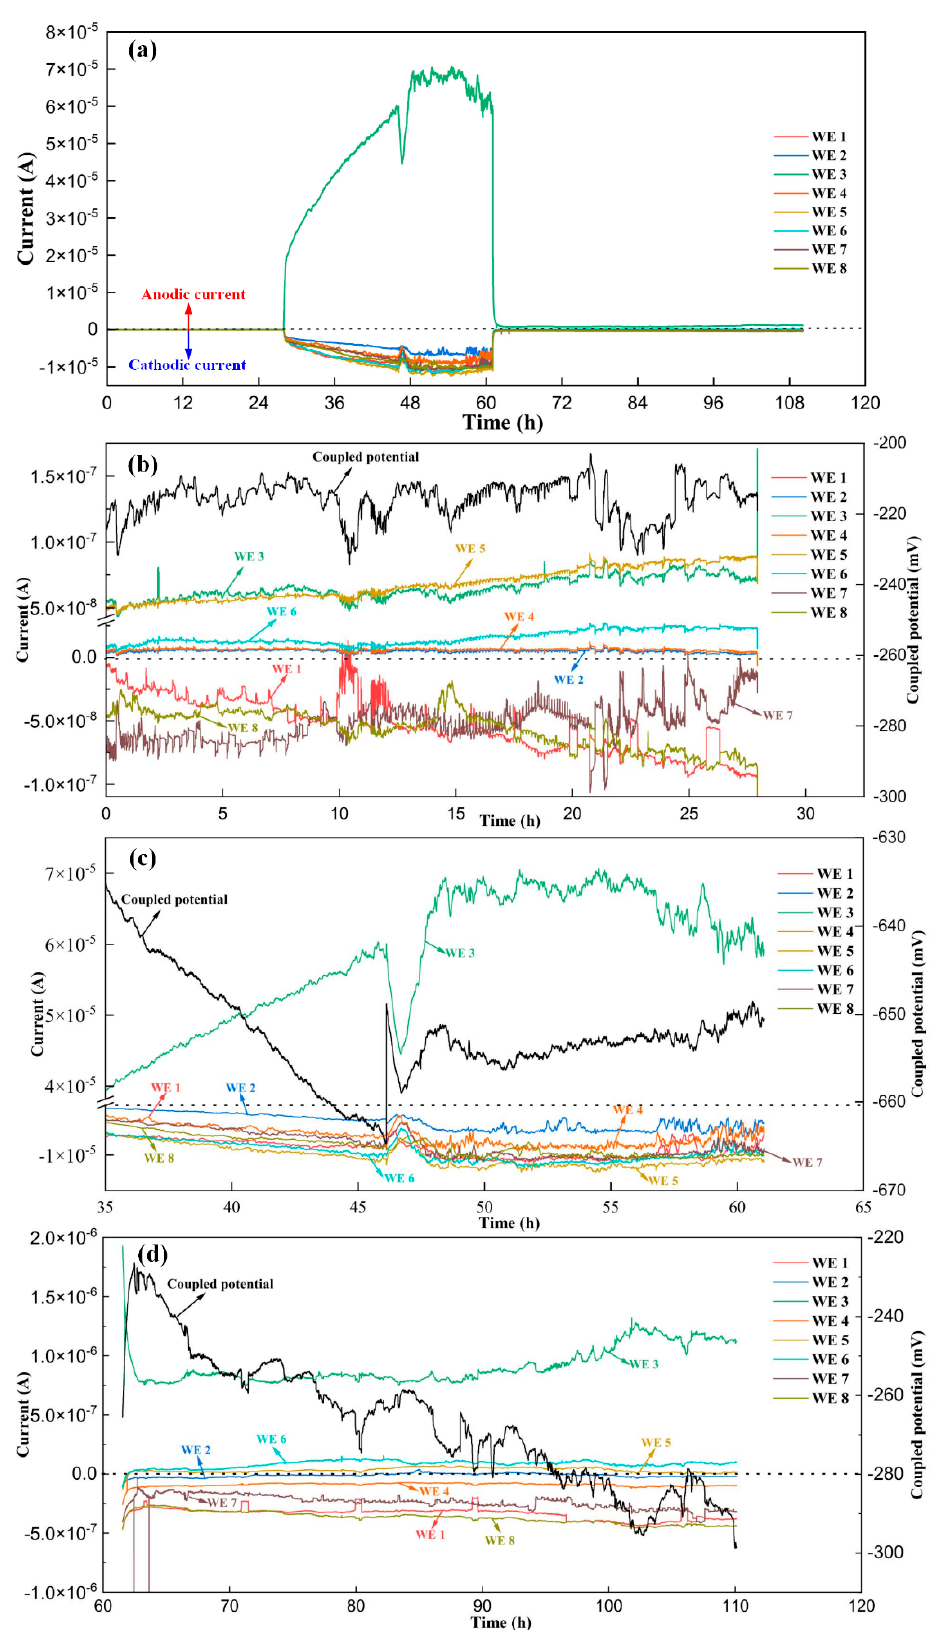
Figure 4. Time dependence of the galvanic currents among the electrodes ( a ), the galvanic currents at 0 h to 28 h ( b ), the galvanic currents at 35 h to 61 h ( c ), and the galvanic currents at 61 h to 110 h ( d ).